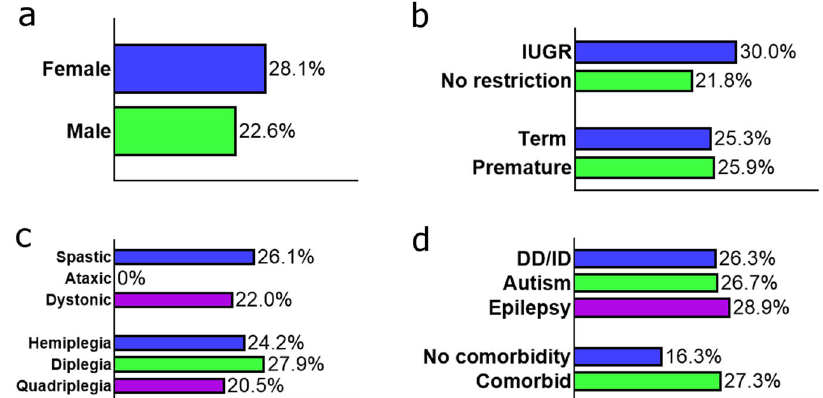
Fig. 2 Percentage of cases with a clinically reportable variant by clinical characteristic. For each clinical characteristic, only individuals for whom data were available are shown, with percentages calculated based on individuals having a variant interpreted as P/LP and causative or a risk factor for CP. Sample sizes : a Sex : Male, n = 93, Female, n = 57; b Neonatal data : Premature, n = 54; Term, n = 83; Intrauterine growth restriction (IUGR), n = 78; No growth restriction, n = 40; c Motor type and topography: Quadriplegia/triplegia, n = 44; Diplegia, n = 43; Hemiplegia, n = 62; Dystonic, n = 41; Ataxic, n = 1; Spastic, n = 142; d Comorbidities: Co-morbid, n = 88; No comorbidity, 49; Autism, n = 15, Developmental delay, n = 76, Epilepsy, n =